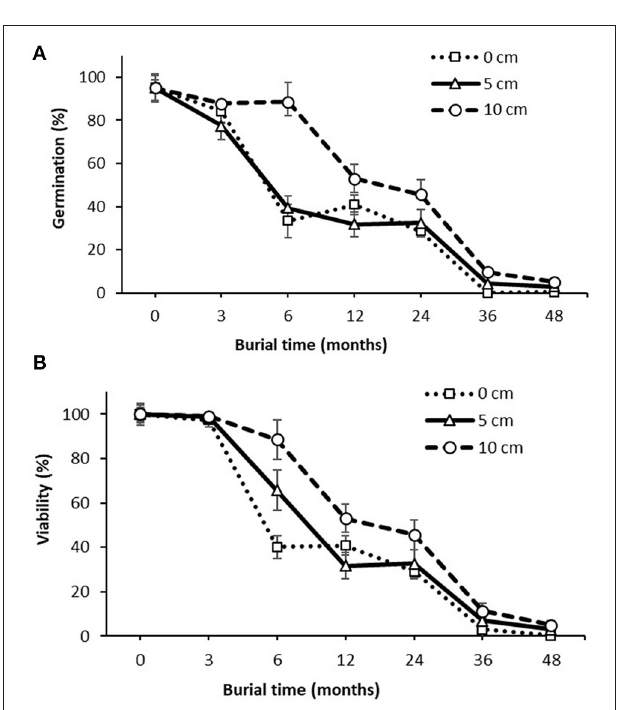
FIGURE 4 | Effect of burial duration and depth on P. capillare seed (A) germination (total germinated seeds from the recovered seeds divided by the buried seeds, %) and (B) viability (total viable seeds from the recovered seeds divided by the buried seeds, %). Vertical bars represent the standard error of the